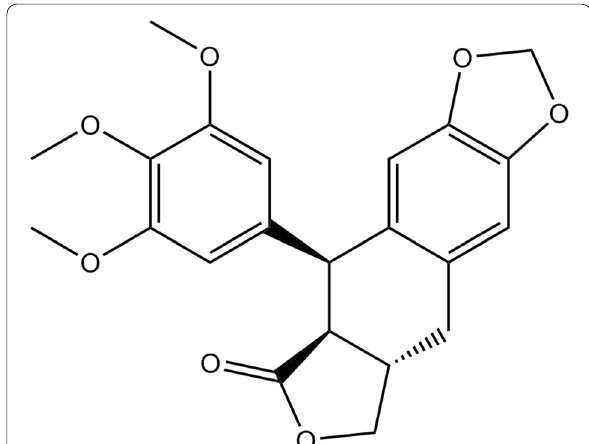
Fig. 1 Structure of deoxypodophyllotoxin